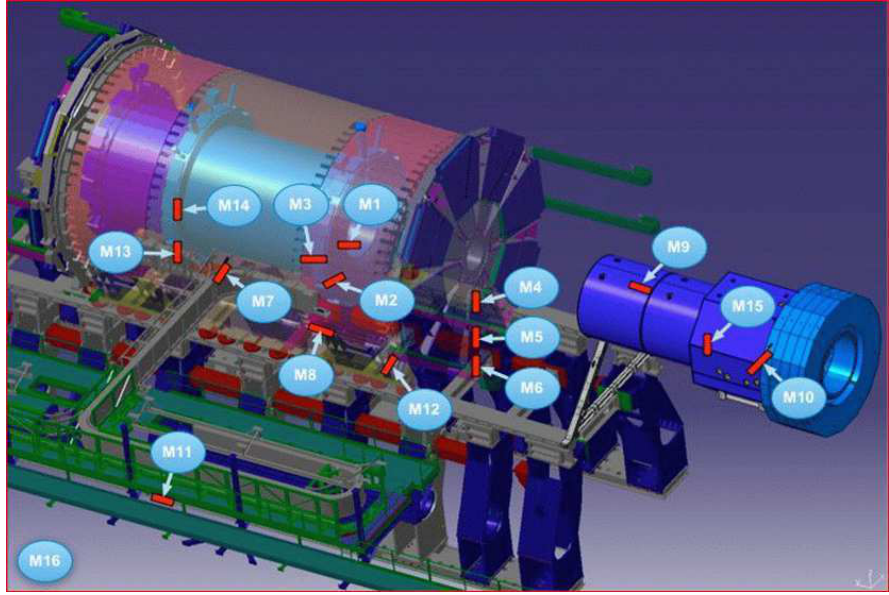
Figure 4. Overview of Medpix-2 (MPX) detector positions in the ATLAS detector (partial illustration) and in the ATLAS experiment cavern. The data of the devices MPX07 to MPX12 (indicated as M7 to M12) were used for the neutron counting luminosity measurement. Taken from Ref. [11]. Table 1. Medpix-2 (MPX) device locations with respect to the interaction point. Z is the longitudinal distance from the interaction point and R is the distance from the beam axis. Only devices with low cluster rates are used for the heavy blob (thermal neutron) counting analysis as indicated. Ordering in the table is given with decreasing particle flux. The asterisk symbol ∗ indicates the device which was rejected during analysis (Section 2.2). Taken from Ref. [11]. Measured MPX Clusters per Unit Sensor Area and per Device Z (m) R (m) Used for th.Neutron Unit Luminosity ( cm − 2 /nb − 1 )